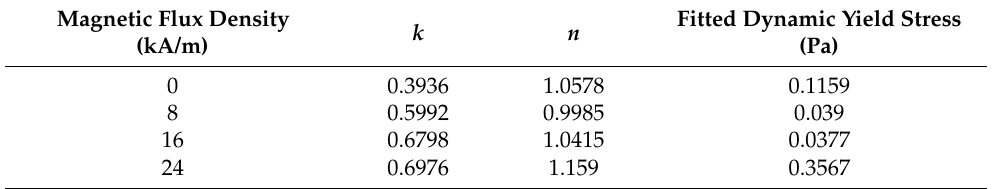
equilibrium structure of the material and formation of steady flow, which is free from the influence of the overall trend of the flow curve. Therefore, the fitting result cannot represent the true dynamic yield stress, and a more convincing method is needed. Table 3. Herschel–Bulkley fitting results on the flow curves of lab-made magnetic fluid. Magnetic Flux Density